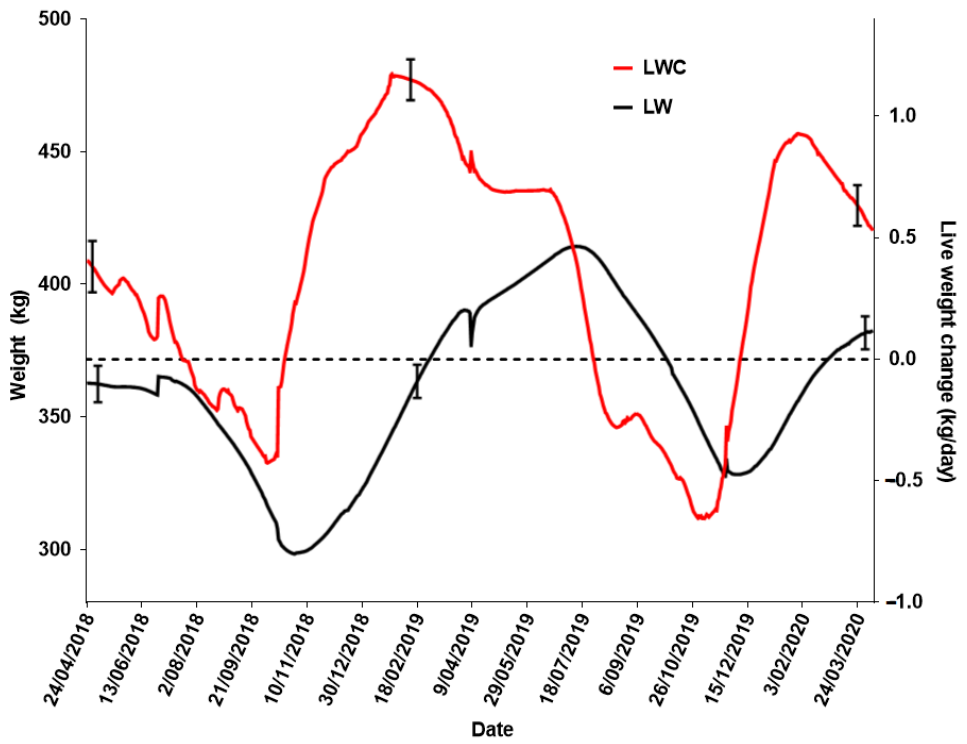
Figure 2. Live weight and live weight change measured using remote automatic weighing systems of cattle grazing in extensive conditions and over the two-year trial period.